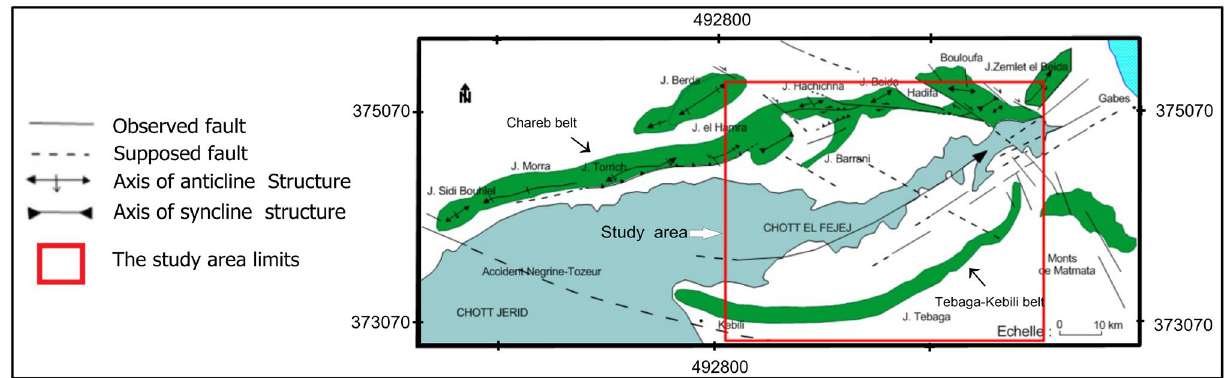
Fig. 3 Chotts belt structural map (Zargouni 1985,